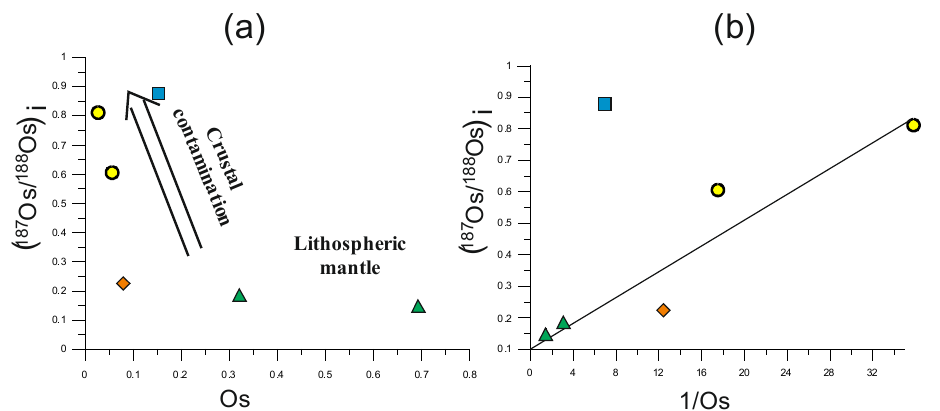
Figure 7. Initial 187 Os/ 188 Os vs. 1/Os ( a ) and vs. Os concentrations ( b ) diagrams. In ( b ), the correlation curve was plotted excluding sample with the highest ( 187 Os/ 188 Os) i . For symbols, see Figure 4.